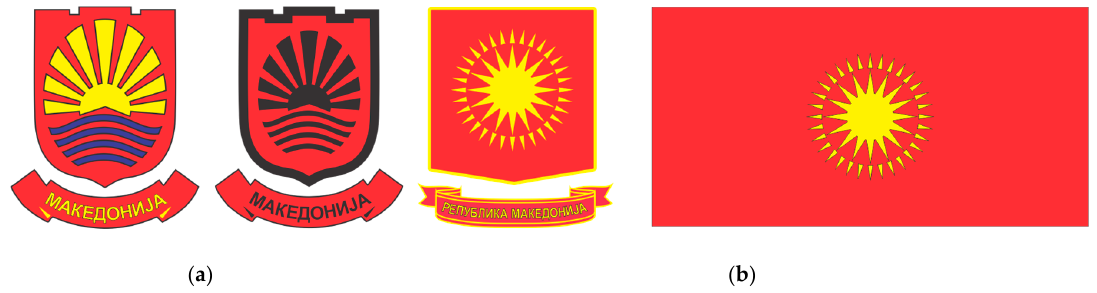
Figure 3. ( a ) Proposals by “5522”; ( b ) The requested proposals by “FENIKS 92” for the arms and the flag.